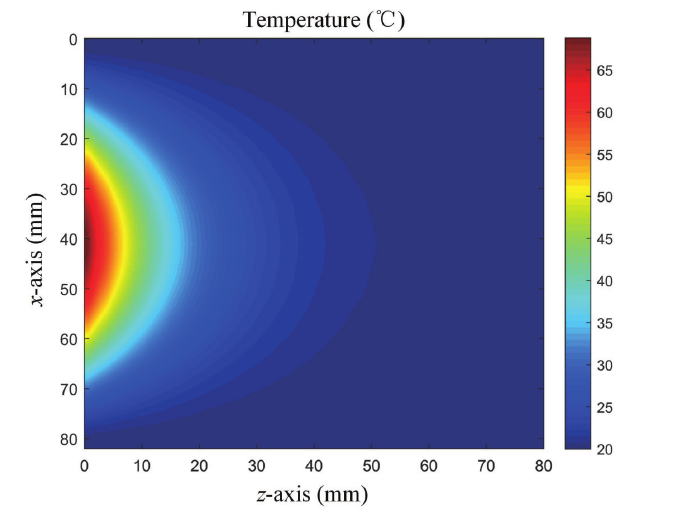
Figure 3. Calculation results of the proposed method.